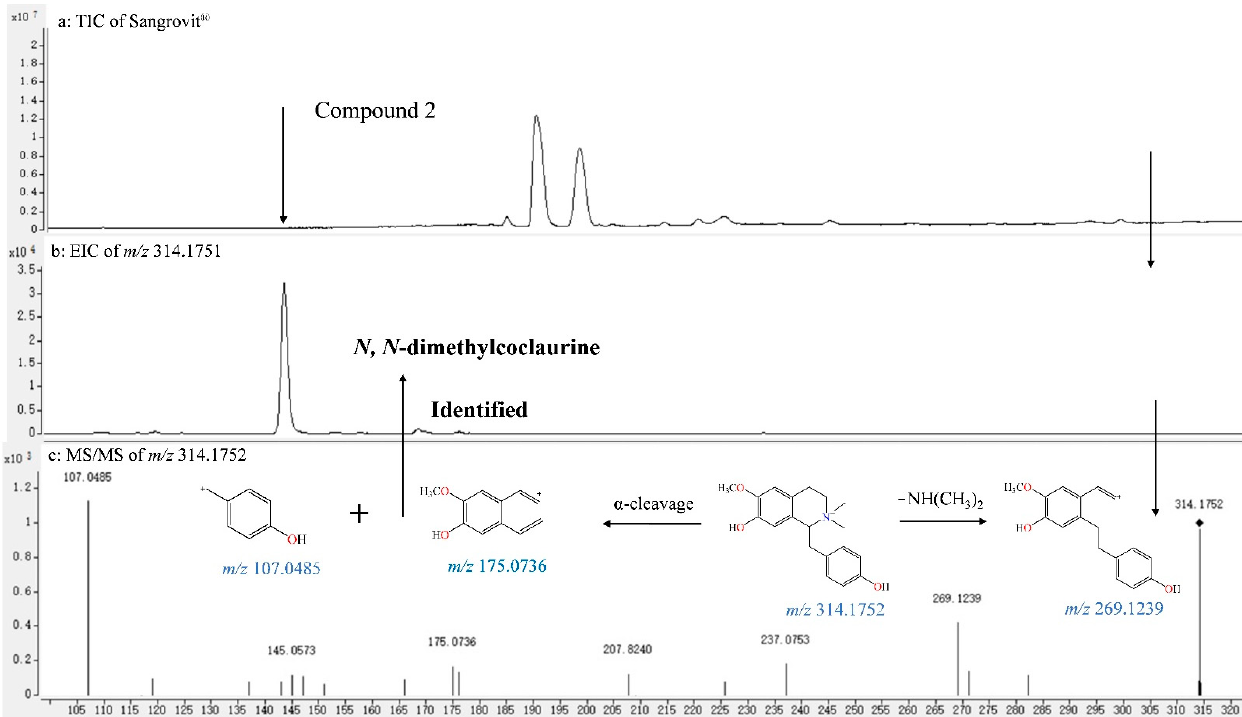
Figure 4. Screening of compound 2 by accurate-target method in the TIC of Sangrovit ® and determination of its structure by the characteristic MS/MS spectrum. ( a ) TIC of Sangrovit ® ; ( b ) EIC of m/z 314.1751; ( c ) MS/MS spectra of m/z 314.1752.